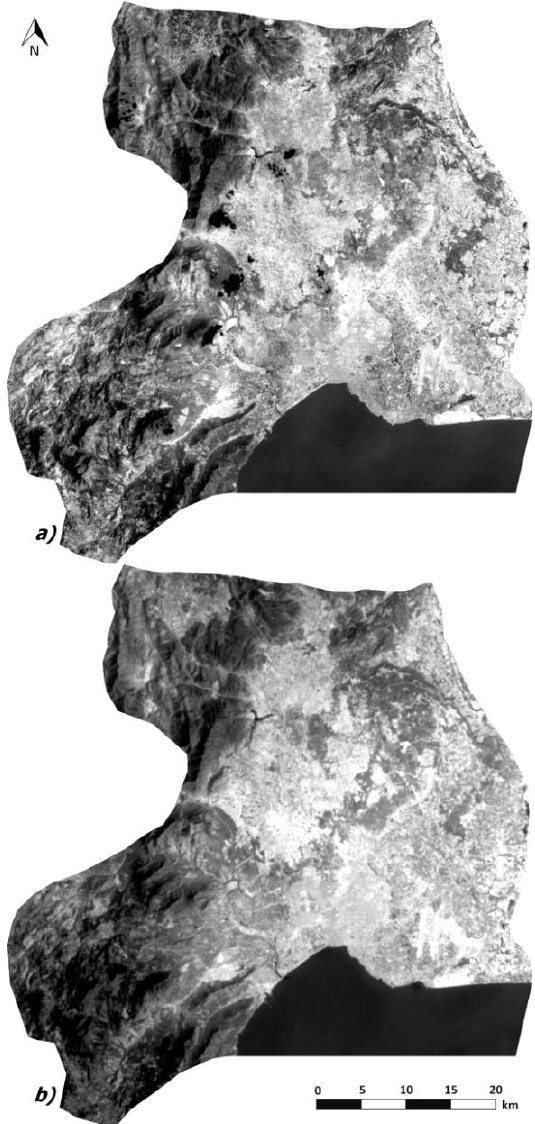
Figure 7. Land Surface Temperatures maps of 2001 Landsat 7 ETM+ (a) 2014 Landsat 8 OLI/TIRS (b) imageries. The validity of the study was tested using MODIS LST/Emissivity data. MODIS LST values were rescaled by